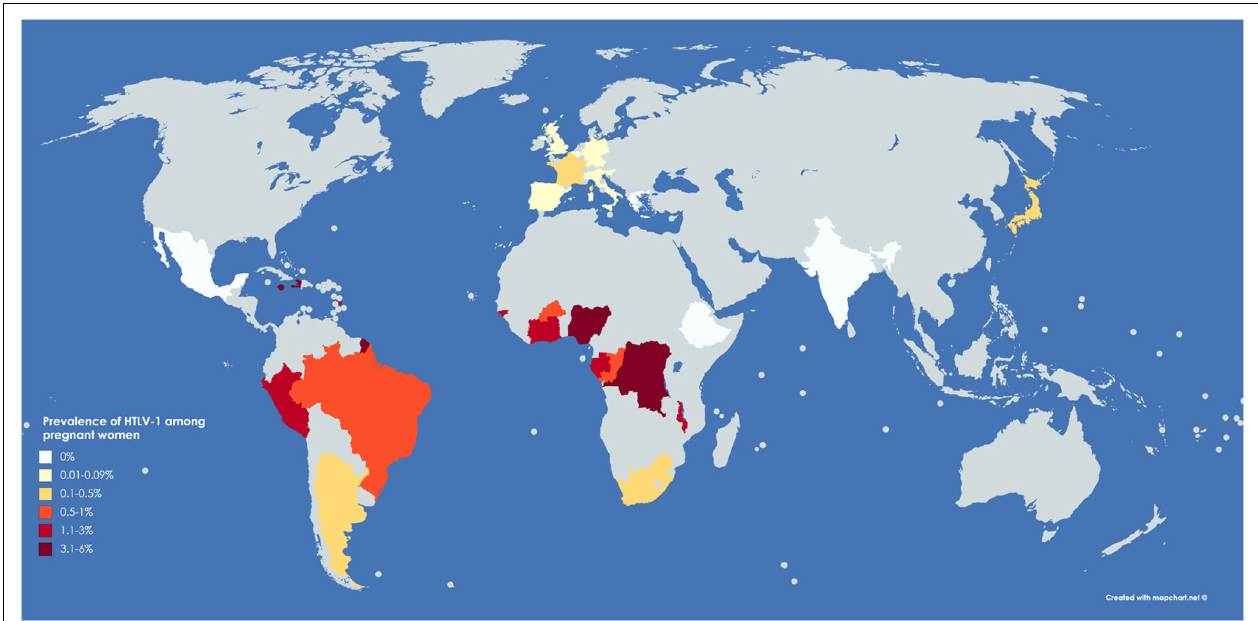
FIGURE 1 | Representative map of world prevalence of HTLV-1 in pregnant women. Original figure created with mapchart.net. Areas in pale gray are those with unknown HTLV-1 prevalence in pregnant women.